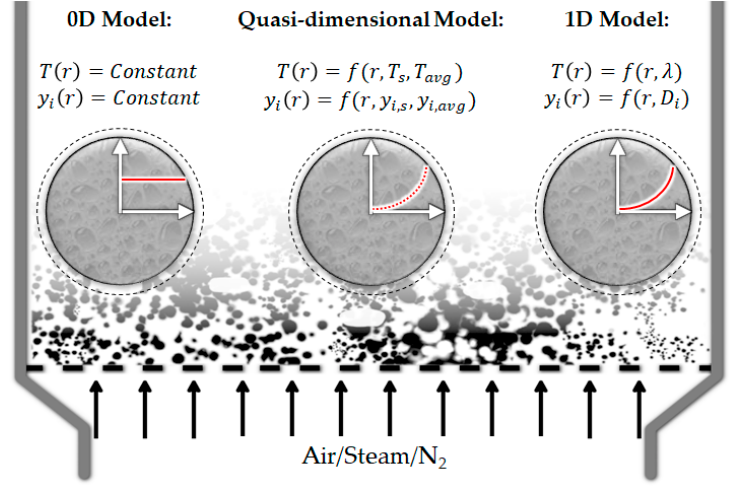
Figure 12. Schematic illustration of different approaches in modeling vaporization (adapted from [209]). The red line and curves are related to the temperature and concentration profiles within the liquid region in a multi-component fuel under vaporization. The dashed circles around the droplets represent the gas-liquid